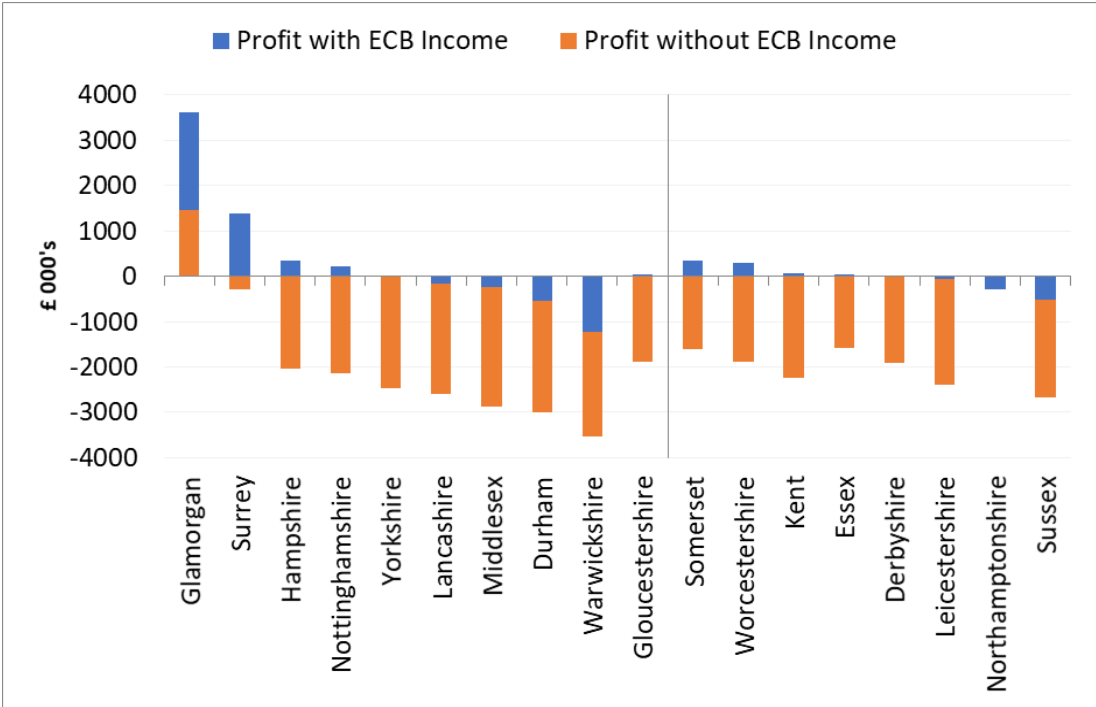
Figure 3. Average profit/(loss) in £000s (2014 – 2016).